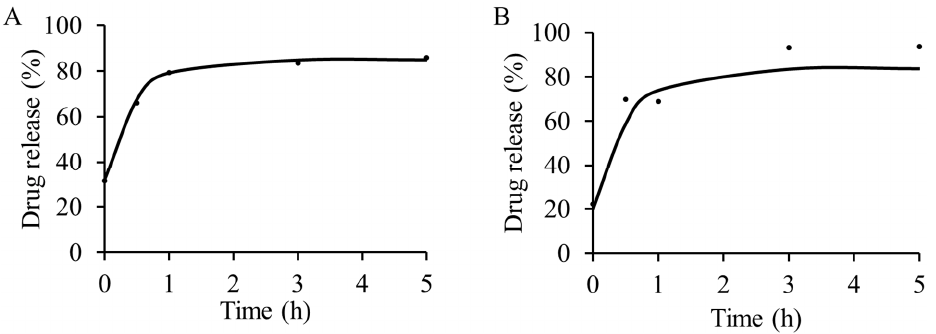
Figure 3. Adsorption of tetracycline (TC) by MCM-41A and MCM-41B. UV-Vis spectra of TC control at 24 h and TC not adsorbed by MCM-41A (green) and MCM-41B (light green). Percent drug adsorption was measured by comparing absorbance at 275